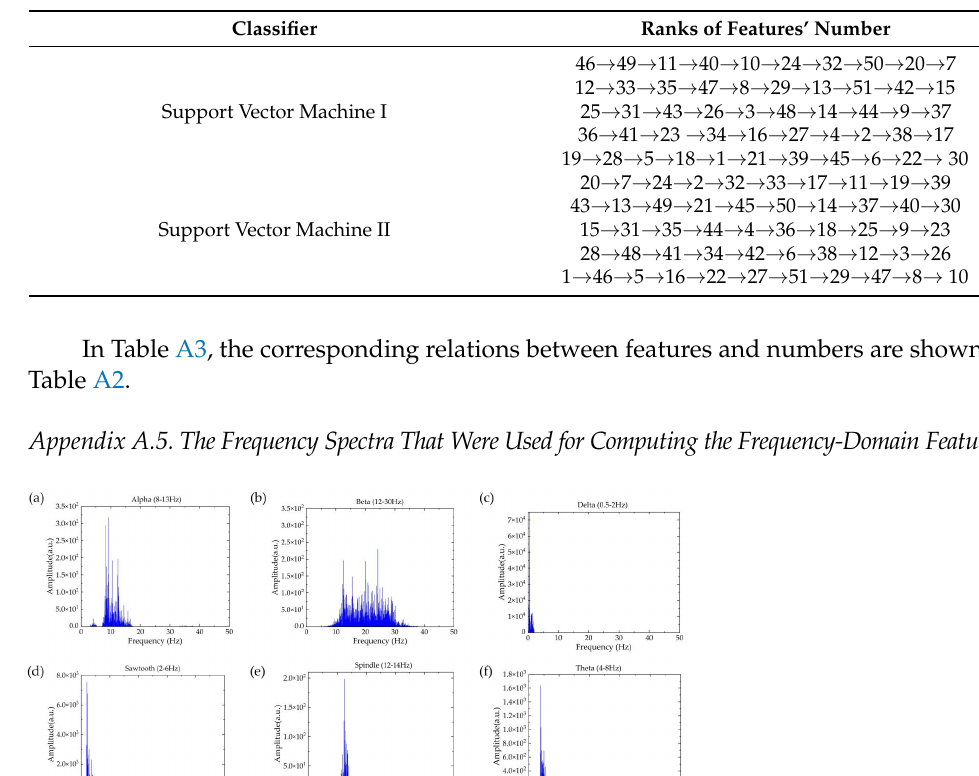
Table A3. The ranks of effective features for different classifiers.